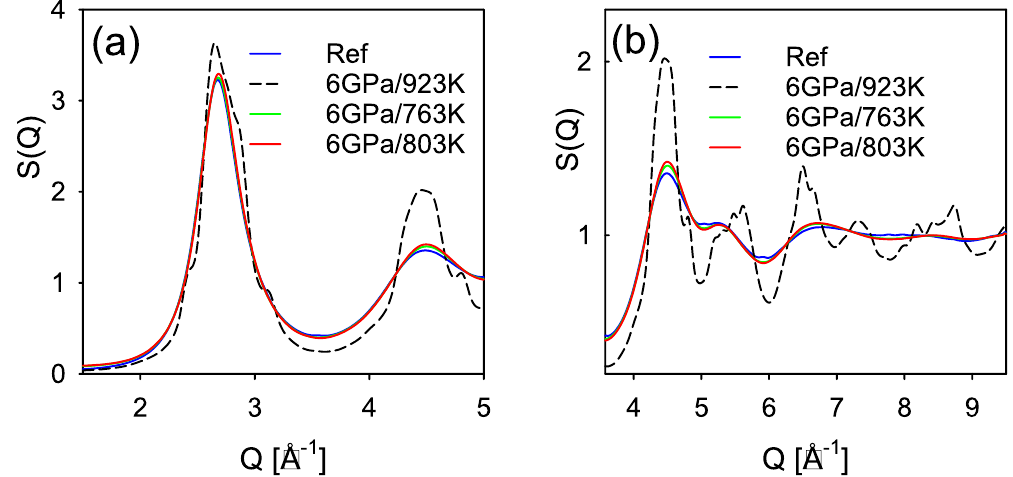
Figure 2. ( a , b ) The structure functions for several HPQ samples of Glass A (Zr 50 Cu 40 Al 10 ) shown in two Q ranges. Panel (a) shows small change in the main peak for various glassy samples. Panel (b) shows significant changes in the higher order peaks and troughs, indicating changes in the atomic short range order. The 923 K/6 GPa sample is clearly nano-crystalline.